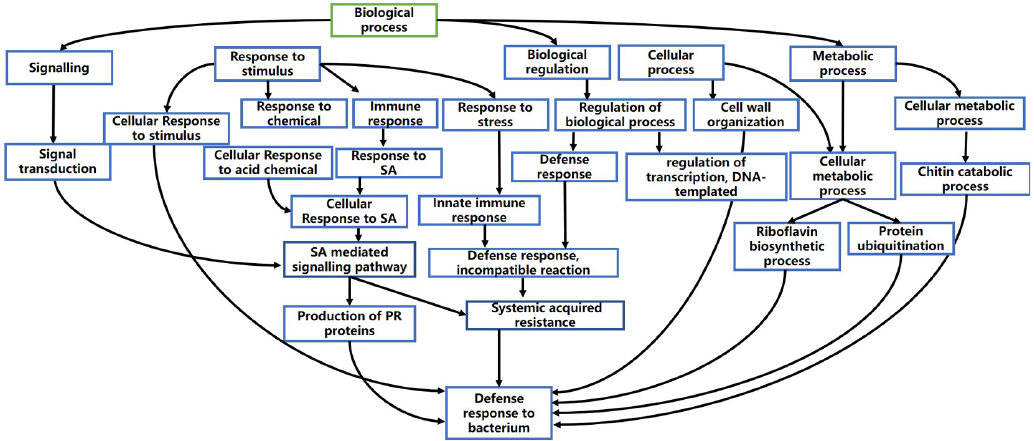
Fig. 3. Directed acyclic graph of defense mechanism in